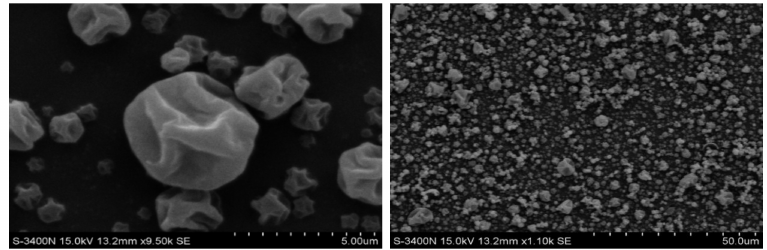
Figure 1. The scanning electron microscope (SEM) images of spray-dried